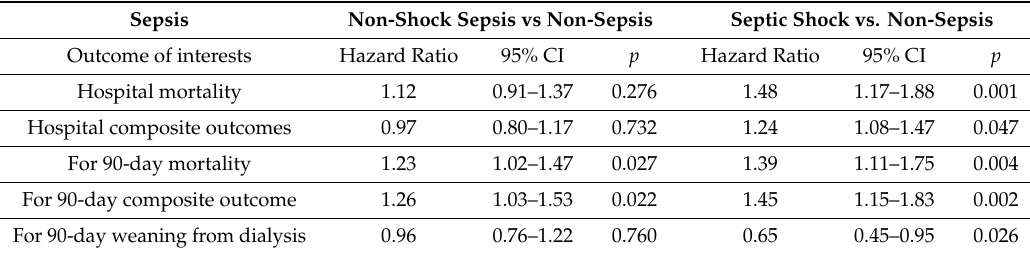
Table 3. Multivariable risk model for hospital mortality or composite outcome at discharge.